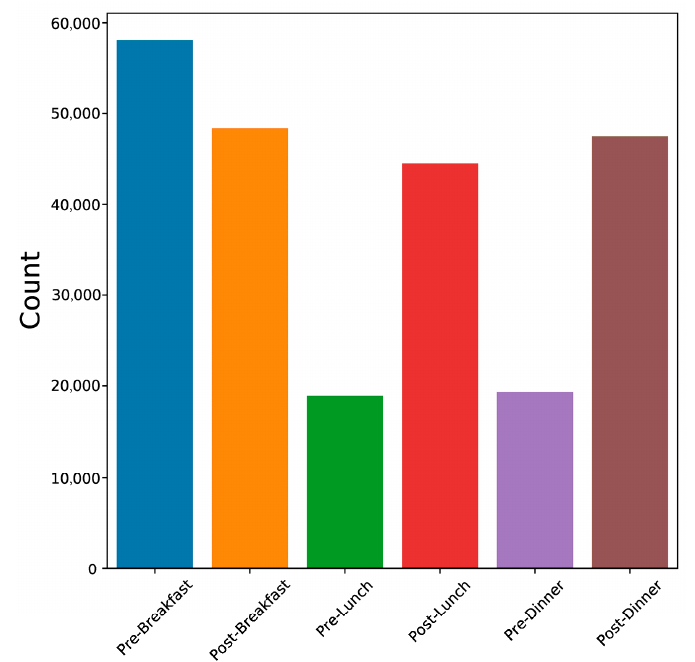
Figure 1. Blood glucose readings for each tag across patients in the OUH cohort. In total, 105,693 readings recorded pre- and post-breakfast, 62,923 recorded pre- and post-lunch, and 66,429 recorded pre- and post-dinner.